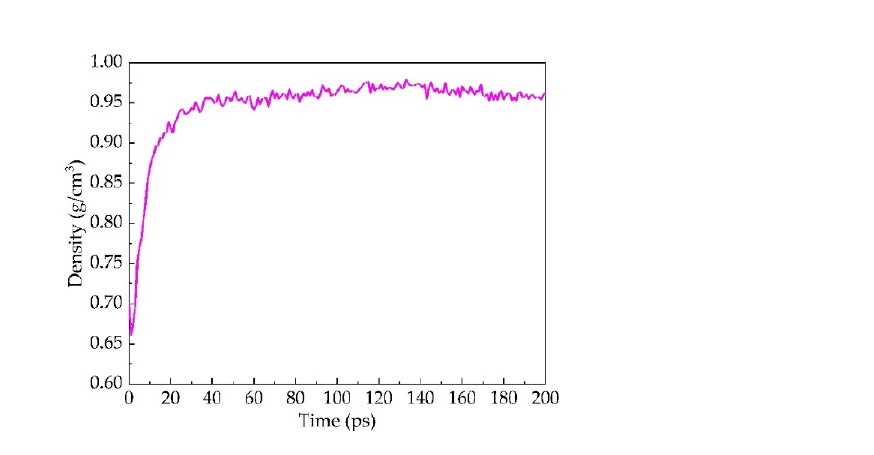
Figure 6. The new-old asphalt interface model diffusion process: ( a ) t = 0 ps; ( b ) t = 3 ps and ( c ) t = 20 ps.